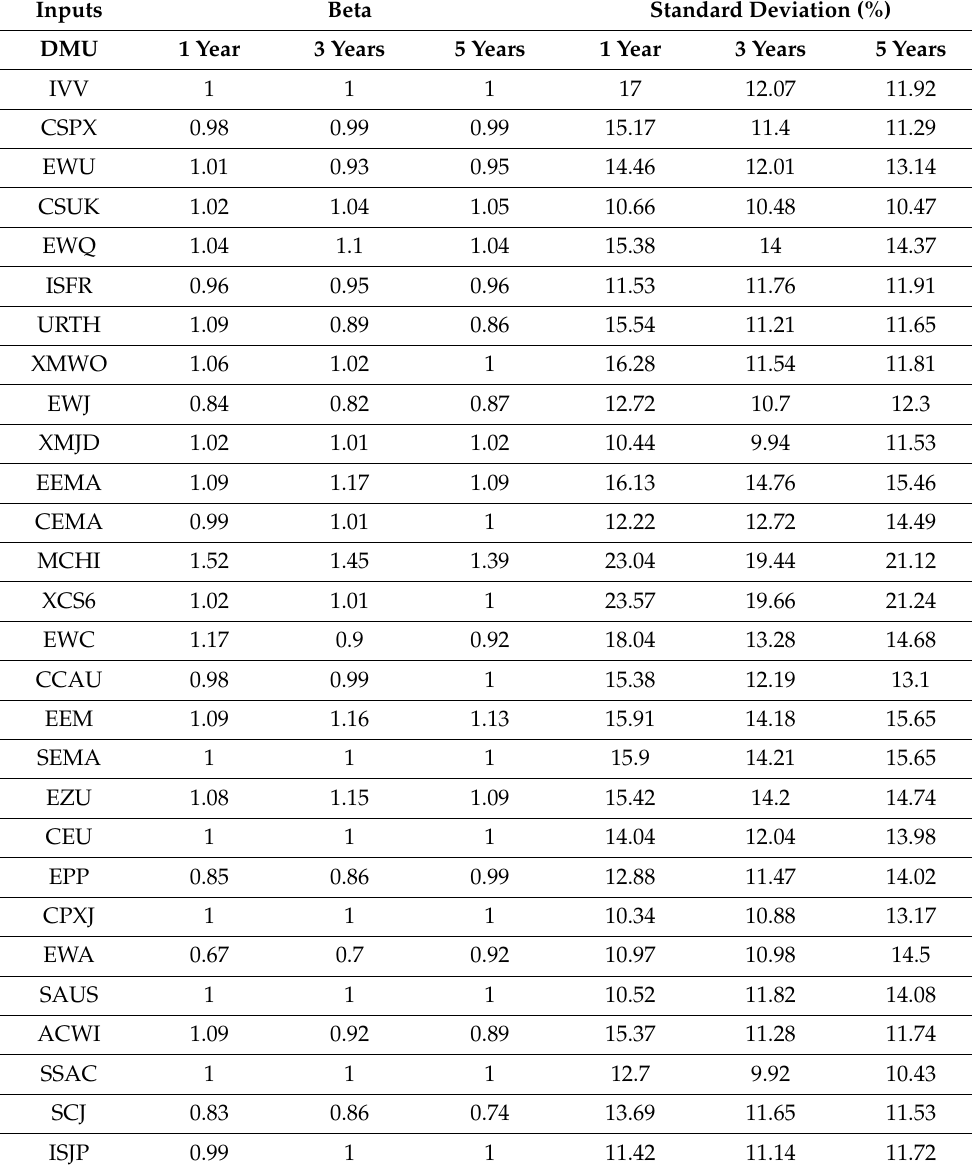
Table A2. Input-related